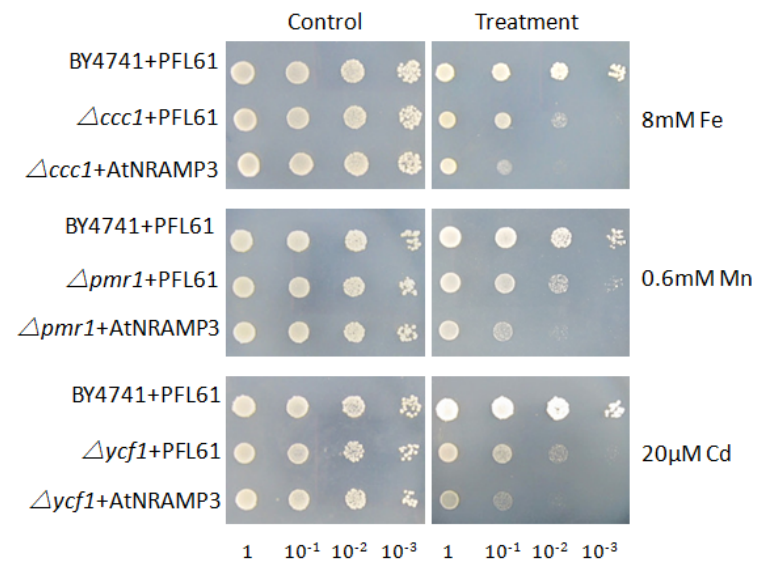
Figure 1. AtNRAMP3 is an Mn, Fe and Cd transporter. Wild-type and mutant yeast strains containing the empty vector or AtNRAMP3 were spotted onto synthetic dropout (SD)-Ura plates with metal supplementation as indicated.